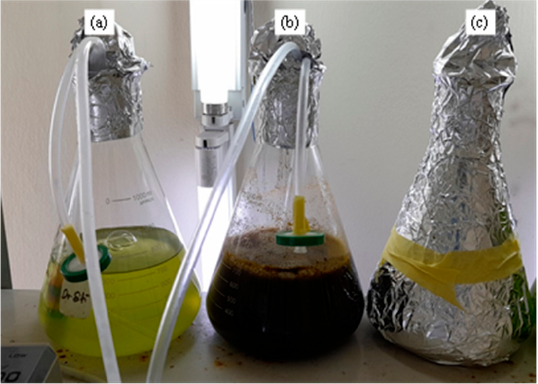
Figure 1. Cultivation conditions for microalgae in various modes: ( a ) autotrophic, ( b ) mixotrophic, and ( c ) heterotrophic. and ( c )